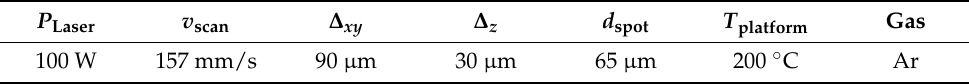
Table 2. Overview of LBM parameters used to build tensile